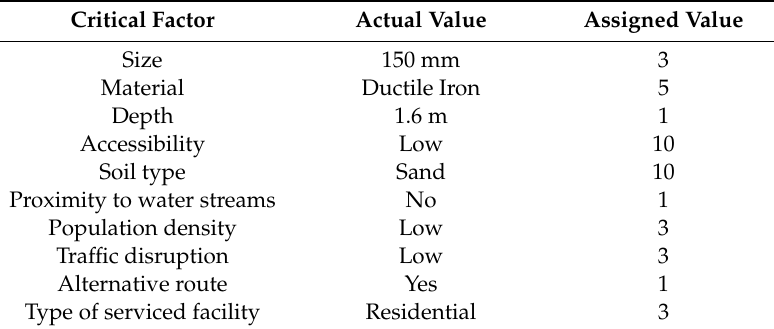
Table 5. Criticality computation for a pipe segment in LWDN.